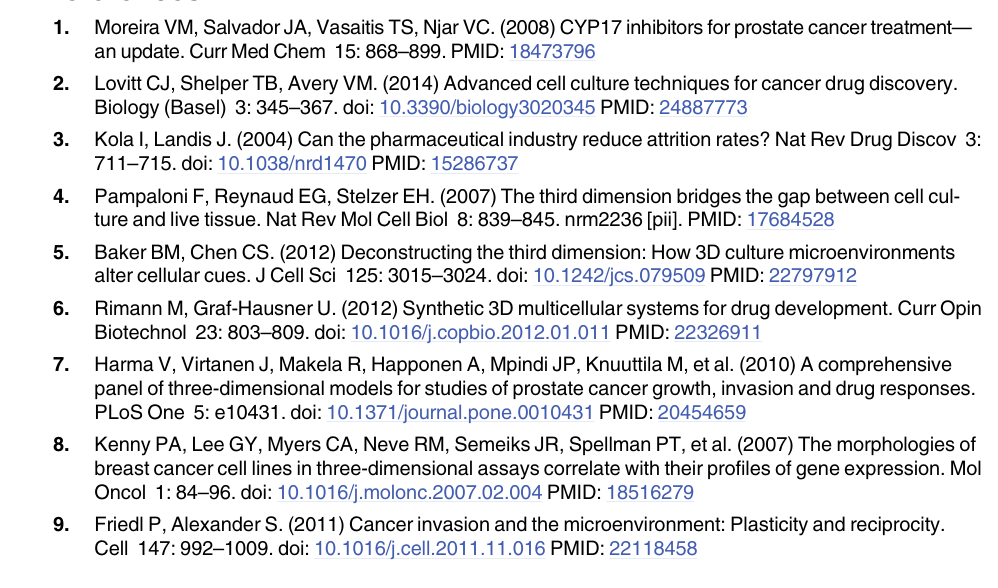
S8 Fig. Cell cycle, proliferation and mitotic analyses. A ) Histograms for DNA content for the cell lines PC-3, LNCaP and Ep156T; exposed to three betulin derivatives 4 , 5 and 20 at 1 μ M concentration for 72 h in monolayer culture. Relative proportions of each cell cycle phase (G1, S and G2), assessed using Flowing software (v2.5.1), are displayed next to each histogram (in %). B ) Expression of proliferating cell nuclear antigen (PCNA) and mitotic cyclin B1 protein in response to 72h exposure to betulin derivatives. 24h paclitaxel treatment was used as mitotic arrest control. S9 Fig. Morphologies of PC-3, LNCaP and Ep156T cells in 2D monolayer culture, exposed 72h to selected betulin derivatives. Actin cytoskeleton (filamentous or F- actin) is stained green (LifeAct), nuclei with a red dye (confocal microscope images, 40× objective, scale bar shown for each panel on the right lower